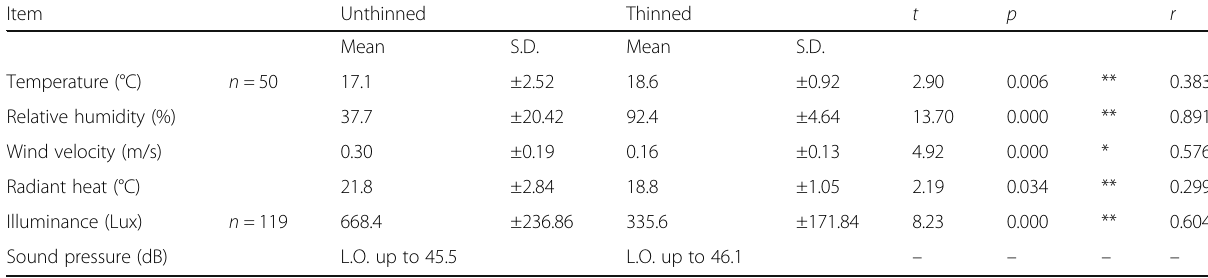
Table 4 Results of t -test comparison between the unthinned and thinned settings (physical environment) Item